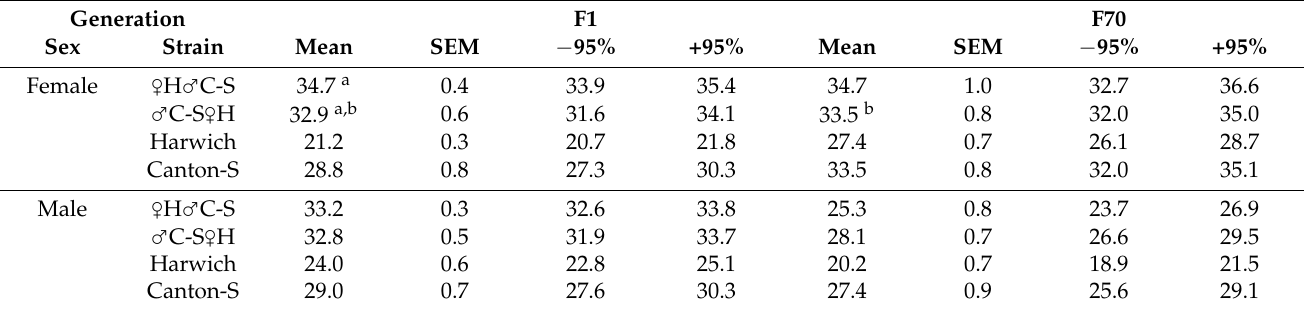
Table 1. Survival time, in days, in two strains and their hybrids of two cross directions kept at 29 °C. Generation